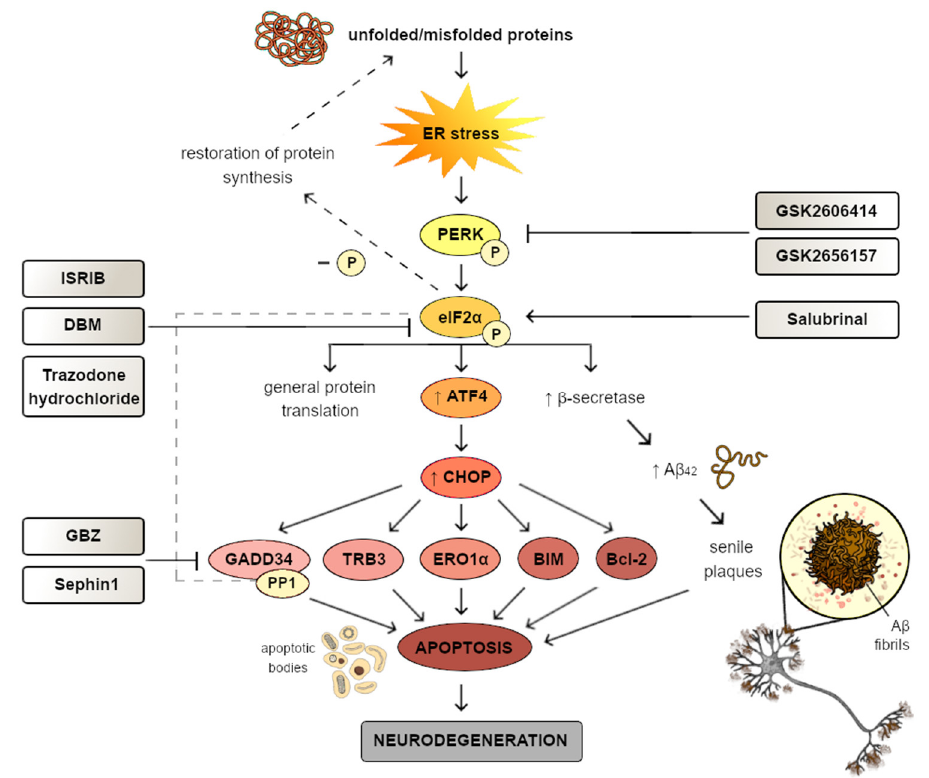
Figure 2. Small-molecule inhibitors of the protein kinase RNA-like endoplasmic reticulum kinase (PERK)-dependent UPR signaling pathway and their targets of action. Numerous studies have suggested that the pathogenesis of neurodegenerative diseases, including Alzheimer’s disease (AD), is correlated with the accumulation of misfolded and unfolded proteins, which may directly or indirectly trigger endoplasmic reticulum (ER) stress conditions and activation of the PERK-dependent unfolded protein response (UPR) signaling pathways. The upregulation of specific mechanisms related to the PERK branch of UPR signaling and AD pathogenesis is indicated by arrow, downregulation by inhibiting line, whereas GADD34-mediated dephosphorylation of eIF2 α in a negative feedback loop by dotted arrow. Under mild-to-moderate ER stress conditions, UPR has a pro-adaptive role, whereas severe or long-termed ER stress conditions directly evoke shift of the UPR toward its pro-apoptotic branch, leading to neurodegeneration. The newest data have reported that pharmacological modulation of the PERK-dependent branch of the UPR signaling pathway via small-molecule inhibitors may constitute a novel treatment strategy against neurodegeneration.